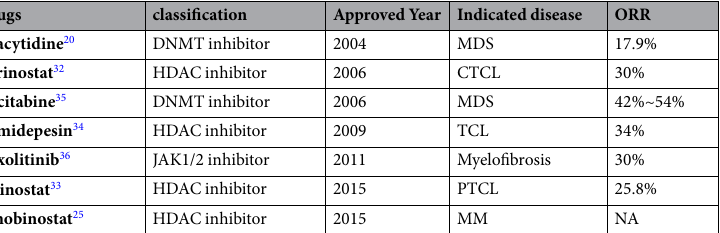
Table 1. Epigenetic drugs approved by FDA. MDS, Myelodysplastic syndrome; CTCL, Cutaneous T-cell lymphoma; TCL, T-cell lymphoma; PTCL, Peripheral T-cell lymphoma; MM, Multiple Myeloma, ORR, Objective response